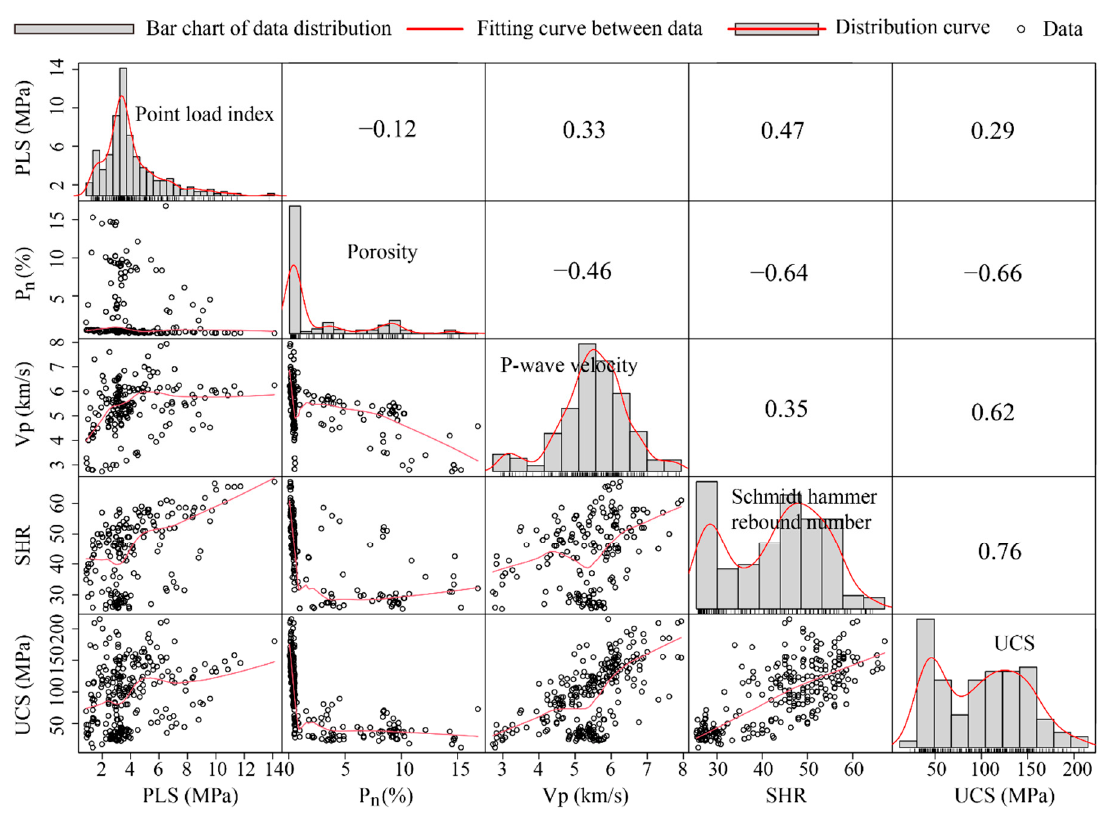
Figure 4. Correlations between input and output variables.